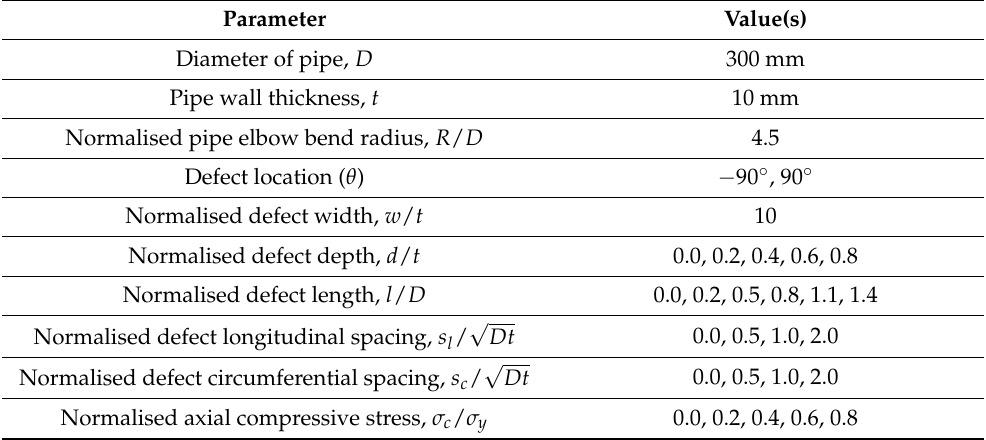
Table 1. Overview of pipe and defect geometry.